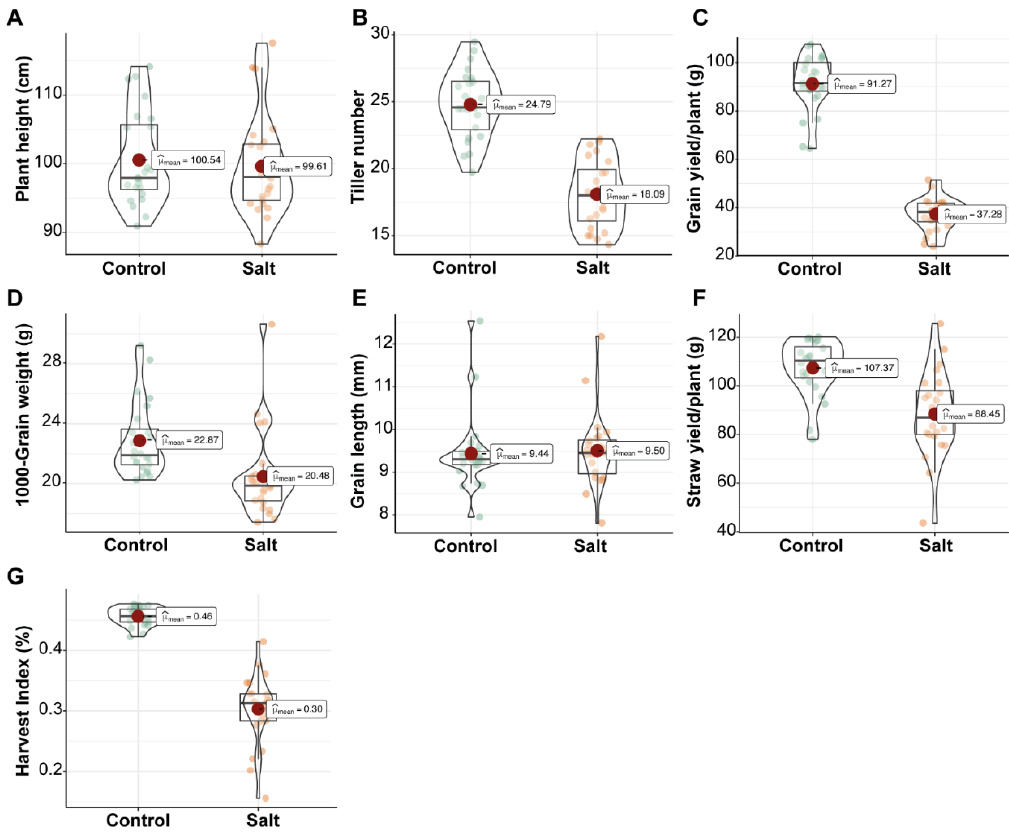
Figure 4. Comparison of yield related parameters ( A – G ) of rice genotypes at maturity stage. Plants were evaluated in control and 200 mM salt stress (salt) under field conditions. Circles with different colors represent the distribution of genotypes. Inside the violin plot, big red circle showed the mean, boxplot represent the median (middle line), minimum, maximum, and error bars. Table 4. Performance of 24 GSR lines under field conditions.